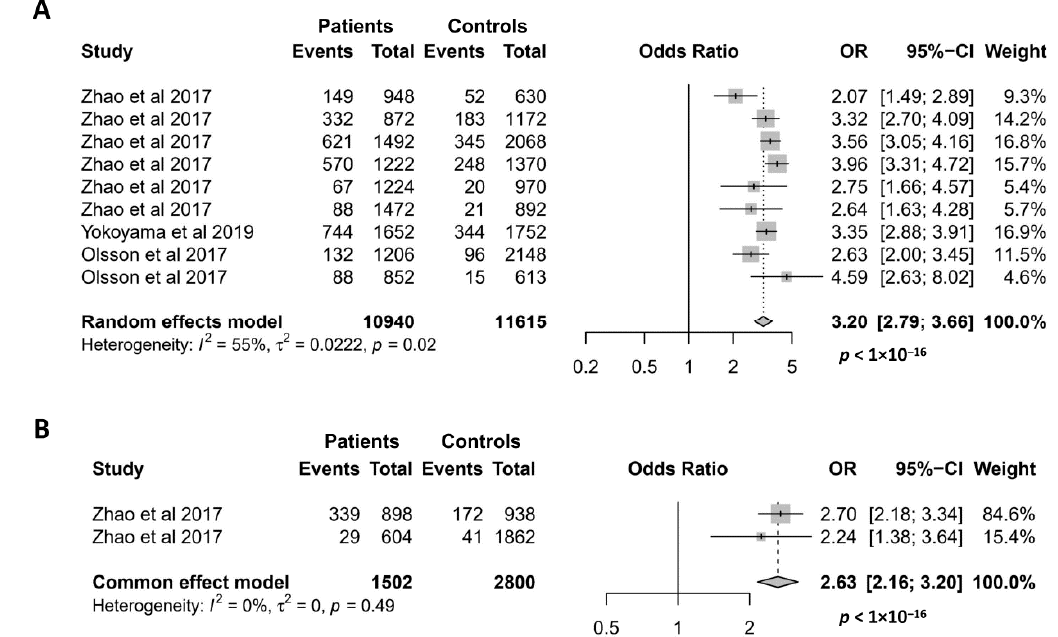
Figure 5. Association of the NCF1 rs201802880 polymorphism with SLE ( A ) and pSS ( B ). Data derived from the meta-analysis are presented as forest plot. Odds ratios (OR) and 95% confidence intervals (CI) of individual studies are represented by squares and horizontal lines, respectively. Size of the square represents the weight of the individual study in the meta-analysis. Diamonds represent the OR (center line of the respective diamond) and 95% CI (lateral tips of the respective diamond). The OR, 95% CI and p values for the meta-analysis are indicated by bold text. Infor-